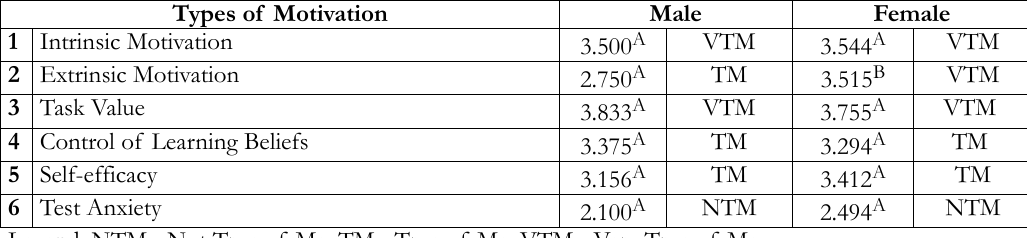
Table 1. The Respondents’ Motivation in Science Learning when Grouped by Sex